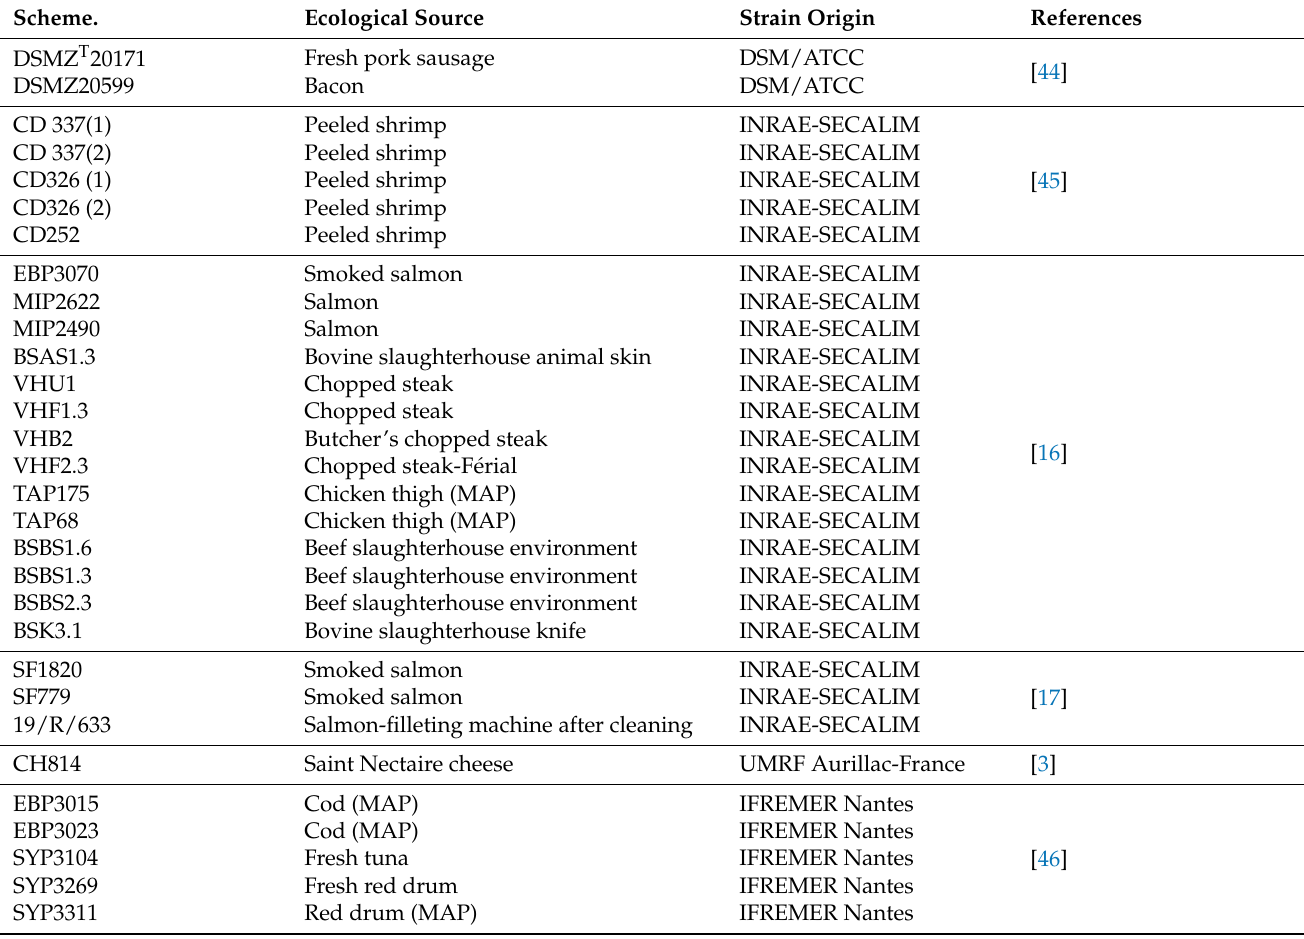
Table 1. Thirty B. thermosphacta strains from multiple